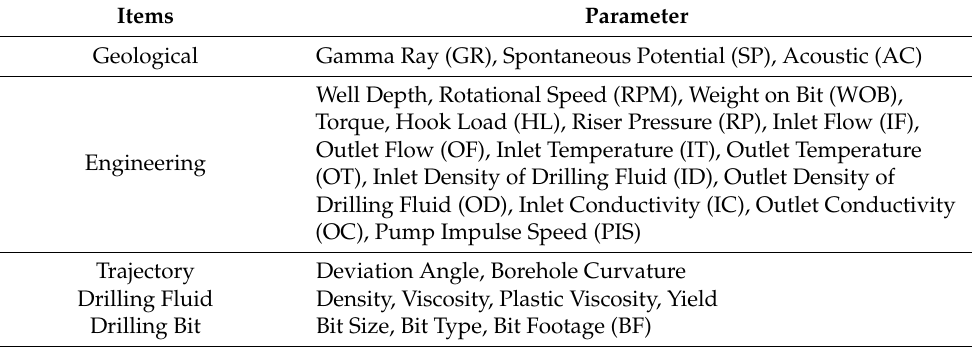
Table 1. Drilling parameters. Items Parameter